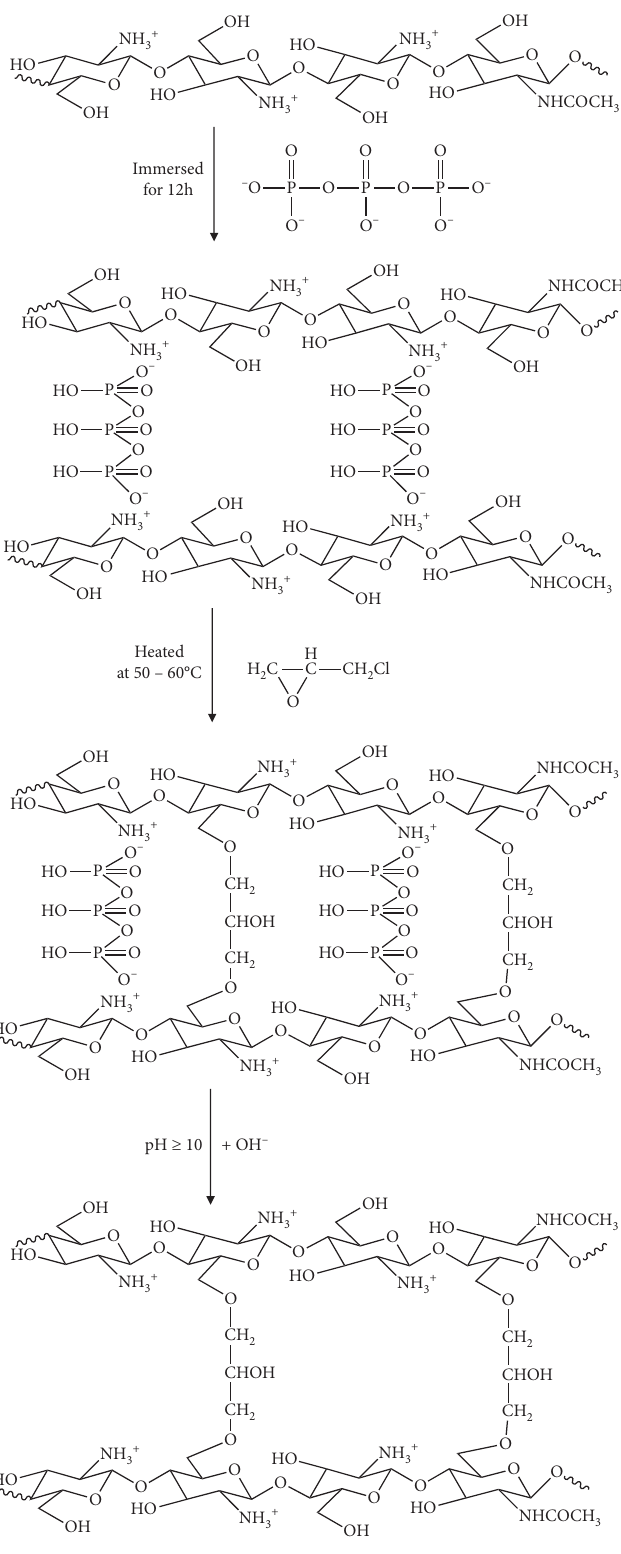
Figure 1: Reaction steps for the preparation of cross-linked chitosan